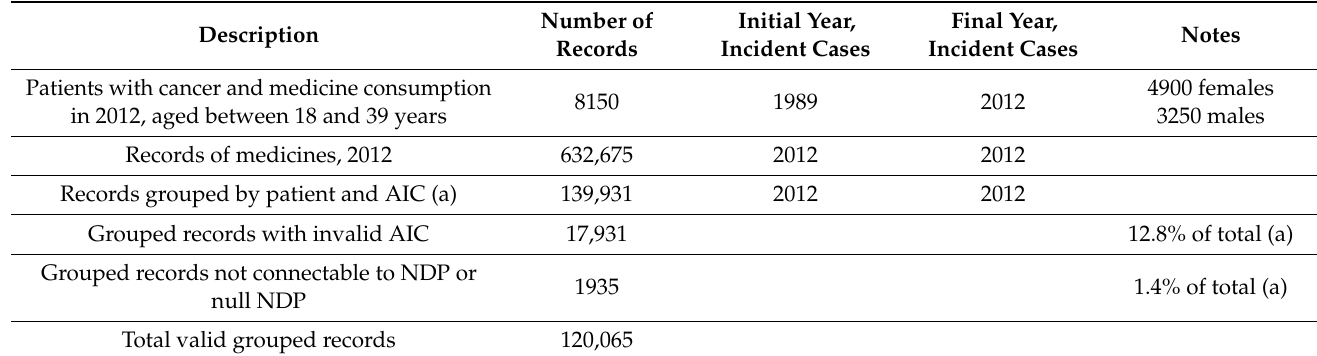
Table 3. Summary of elaborations on pharmaceutical records extracted from Ada database.